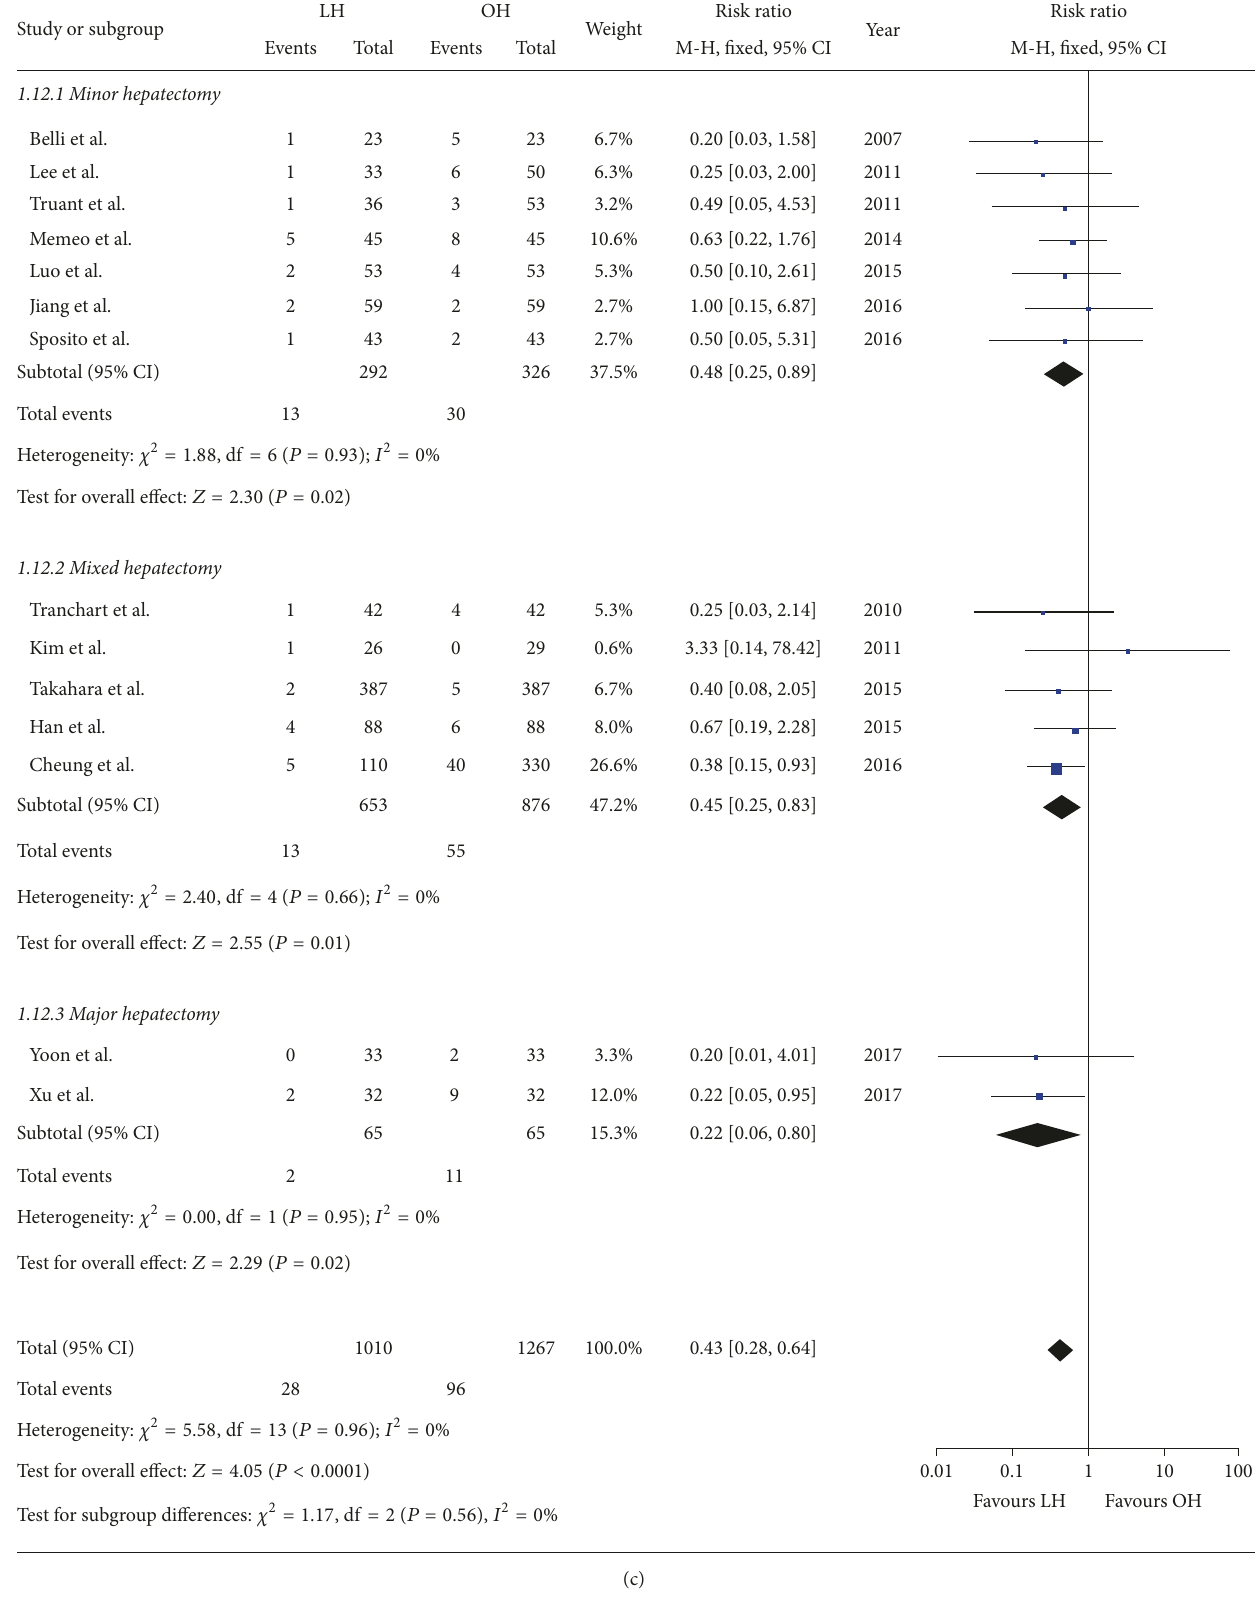
Figure 3: Forest plot of specific complications: (a) ascites, (b) liver failure, (c) respiratory